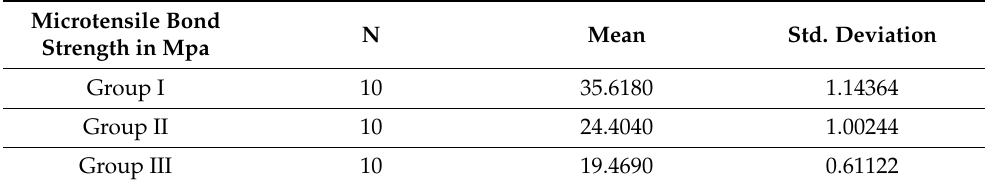
Table 2. Microtensile bond strength in Mpa of three composite resin core materials among the study groups.